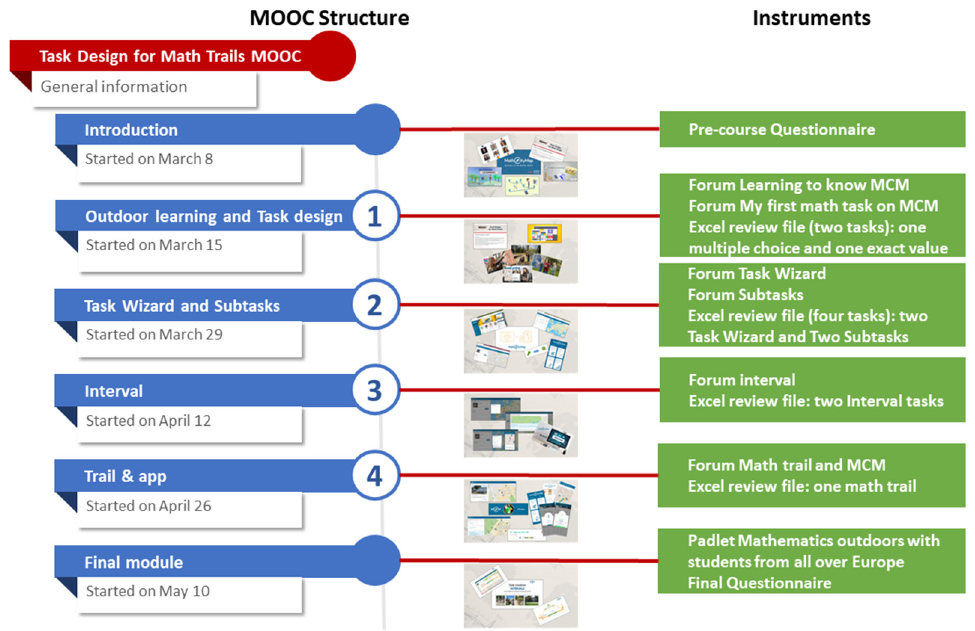
Figure 5. MOOC structure and instruments to collect data.